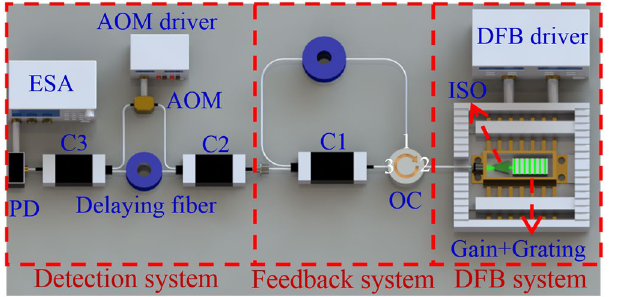
Figure 1. Schematic of the experimental setup. ISO: optical isolator, OC: optical circulator, C1, C2, C3: fiber optic couplers, AOM: acoustic optical modulator, PD: photodetector, ESA: electric spectrum